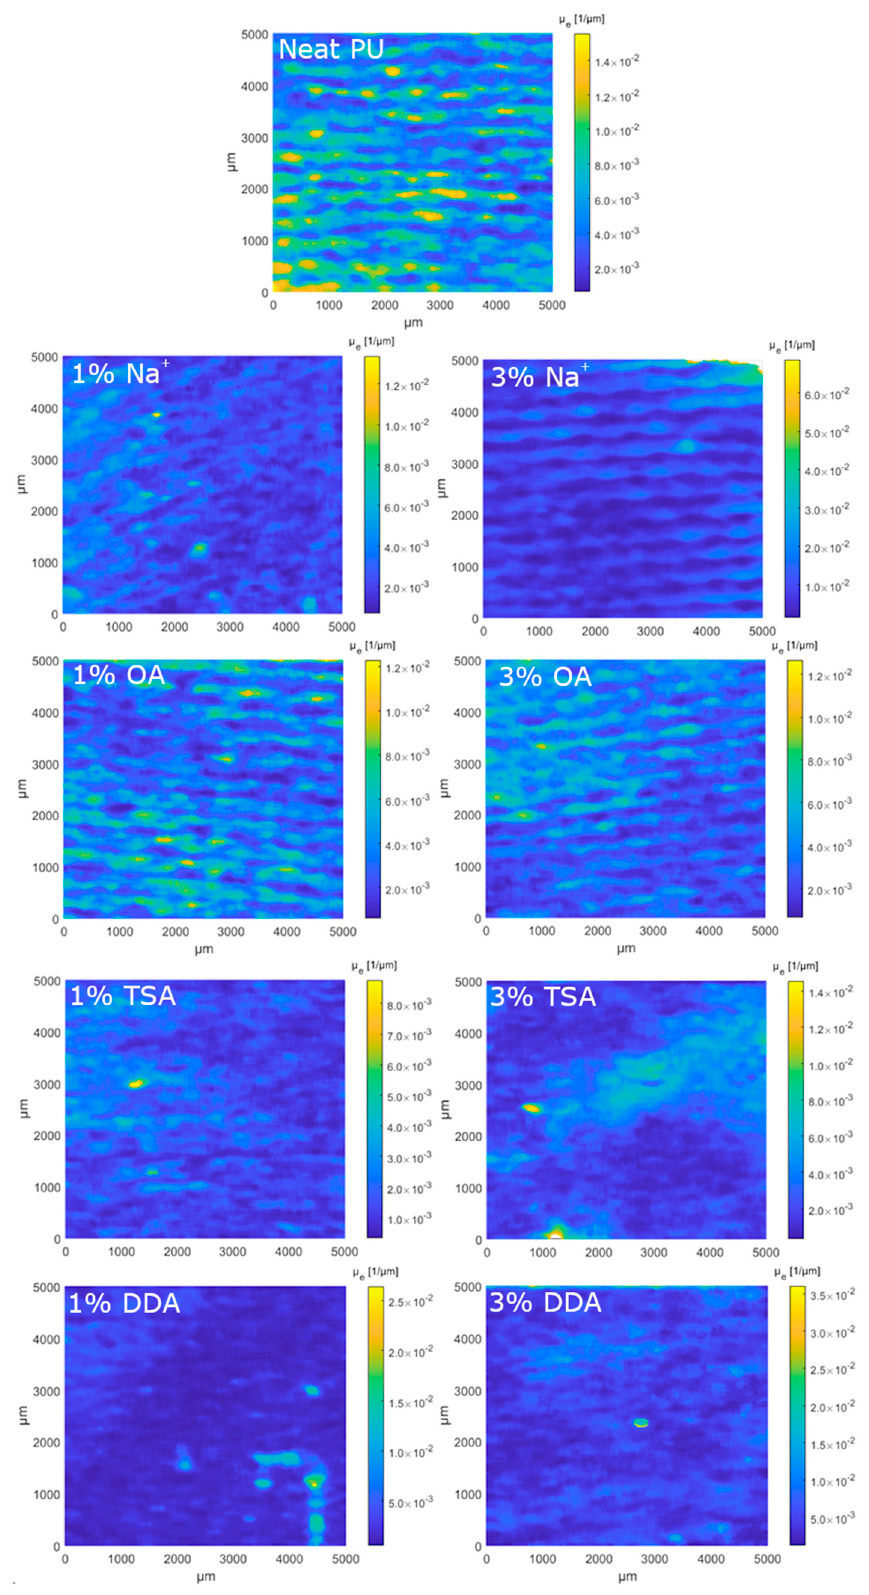
Figure 10. The surface map (according to C-scan plane) of the normalized extinction coefficient.